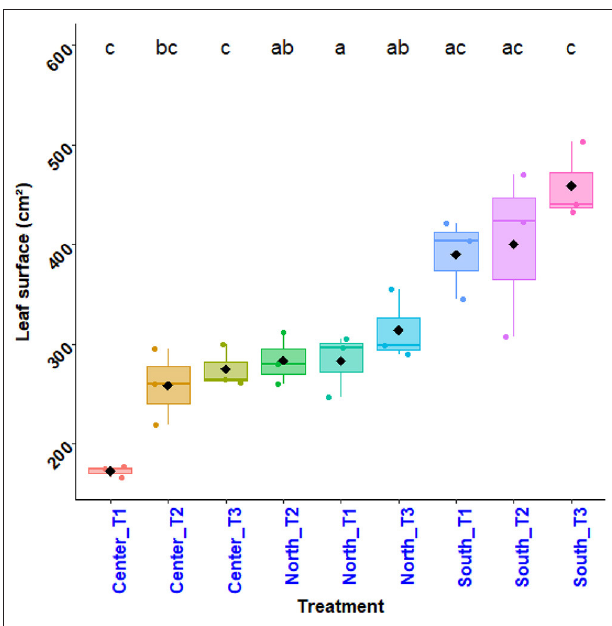
FIGURE 4 | Variation in maize plant leaf area as a function of treatments.